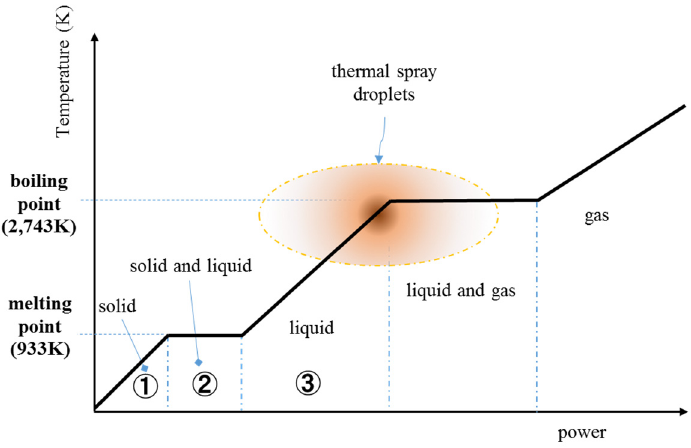
Figure 4. Schematic diagram showing how an input power to a gun is used to heat up spray droplets (abscissa is in a relative unit). The melting and boiling points in the ordinate is for Al.